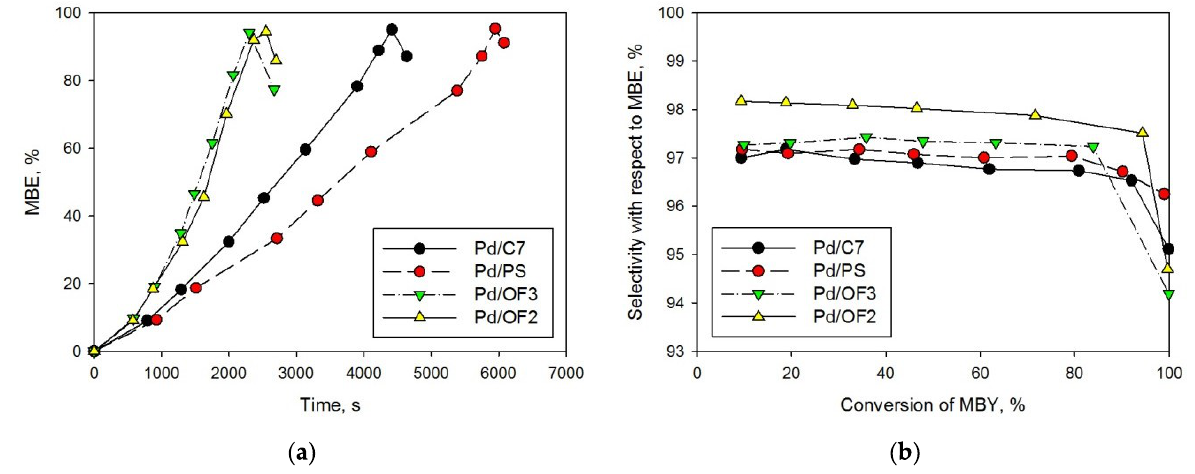
Figure 5. Kinetic curves of 2-methyl-3-buten-2-ol (MBE) accumulation ( a ) and dependence of the selectivity with respect to MBE on MBY conversion of ( b ). Table 1. Data of HPS-based catalysts, testing in hydrogenation ofalkynols (solvent—toluene, temper- ature 90 ◦ C, ambient hydrogen